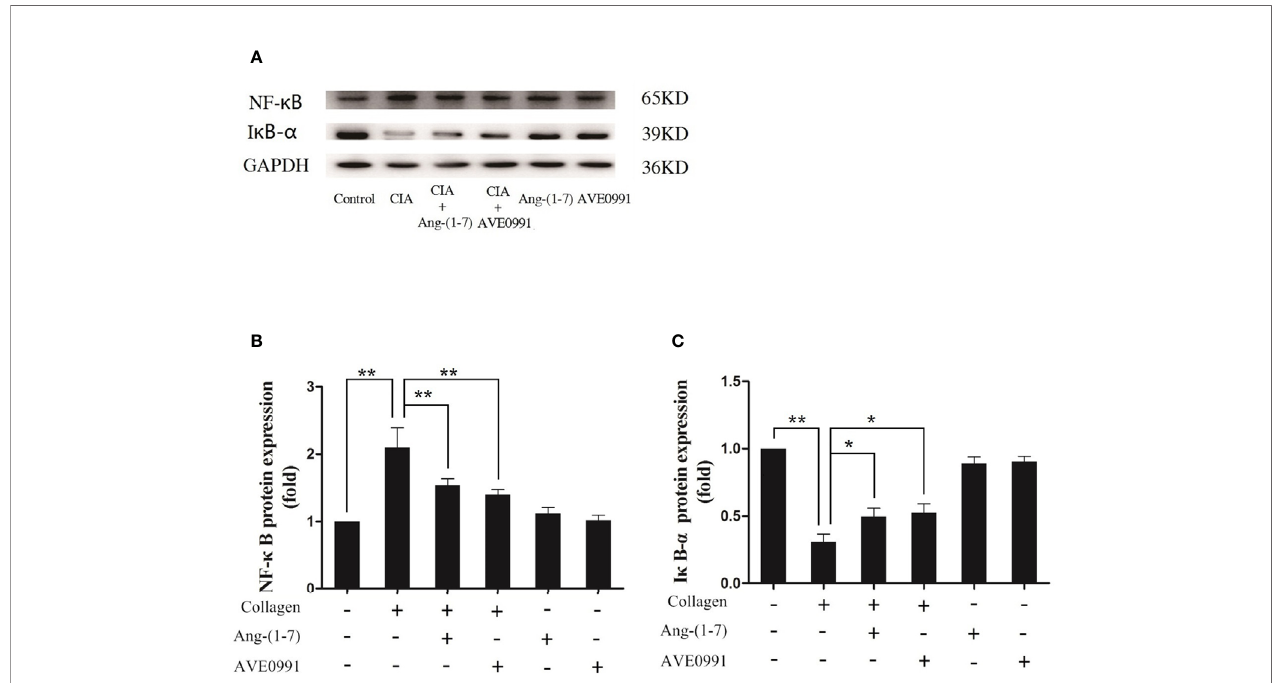
FIGURE 4 | Ang-(1 – 7) and AVE0991 inhibit arthritis-induced NF- k B and increase arthritis-induced I k B- a expression in the ankle. (A) Representative immunoblots for NF- k B and I k B- a . (B) Representative quantitative analysis of NF- k B. (C) Representative quantitative analysis of I k B- a . Values are expressed as means ± SD (n = 6). *P < 0.05, **P < 0.01.